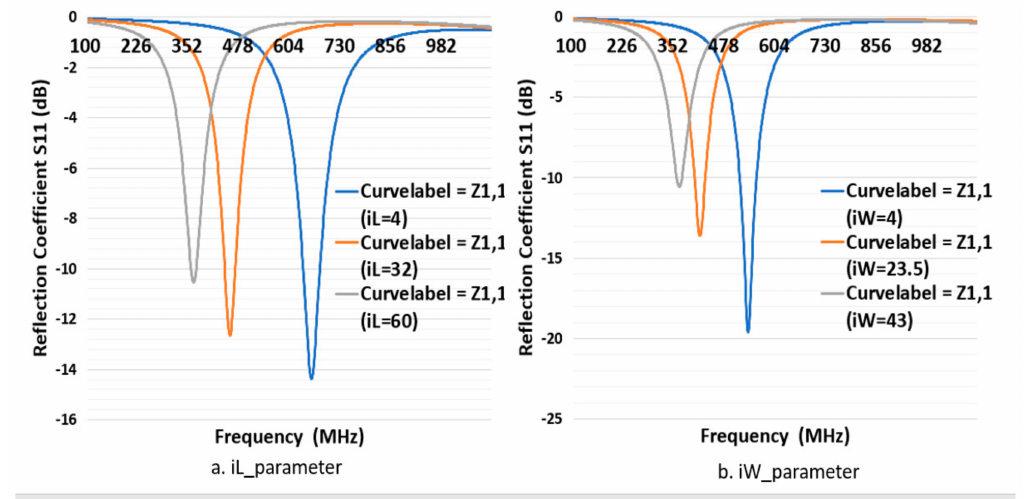
Figure 3. Return loss of the design CFTA M8063 by different parameters of iL and